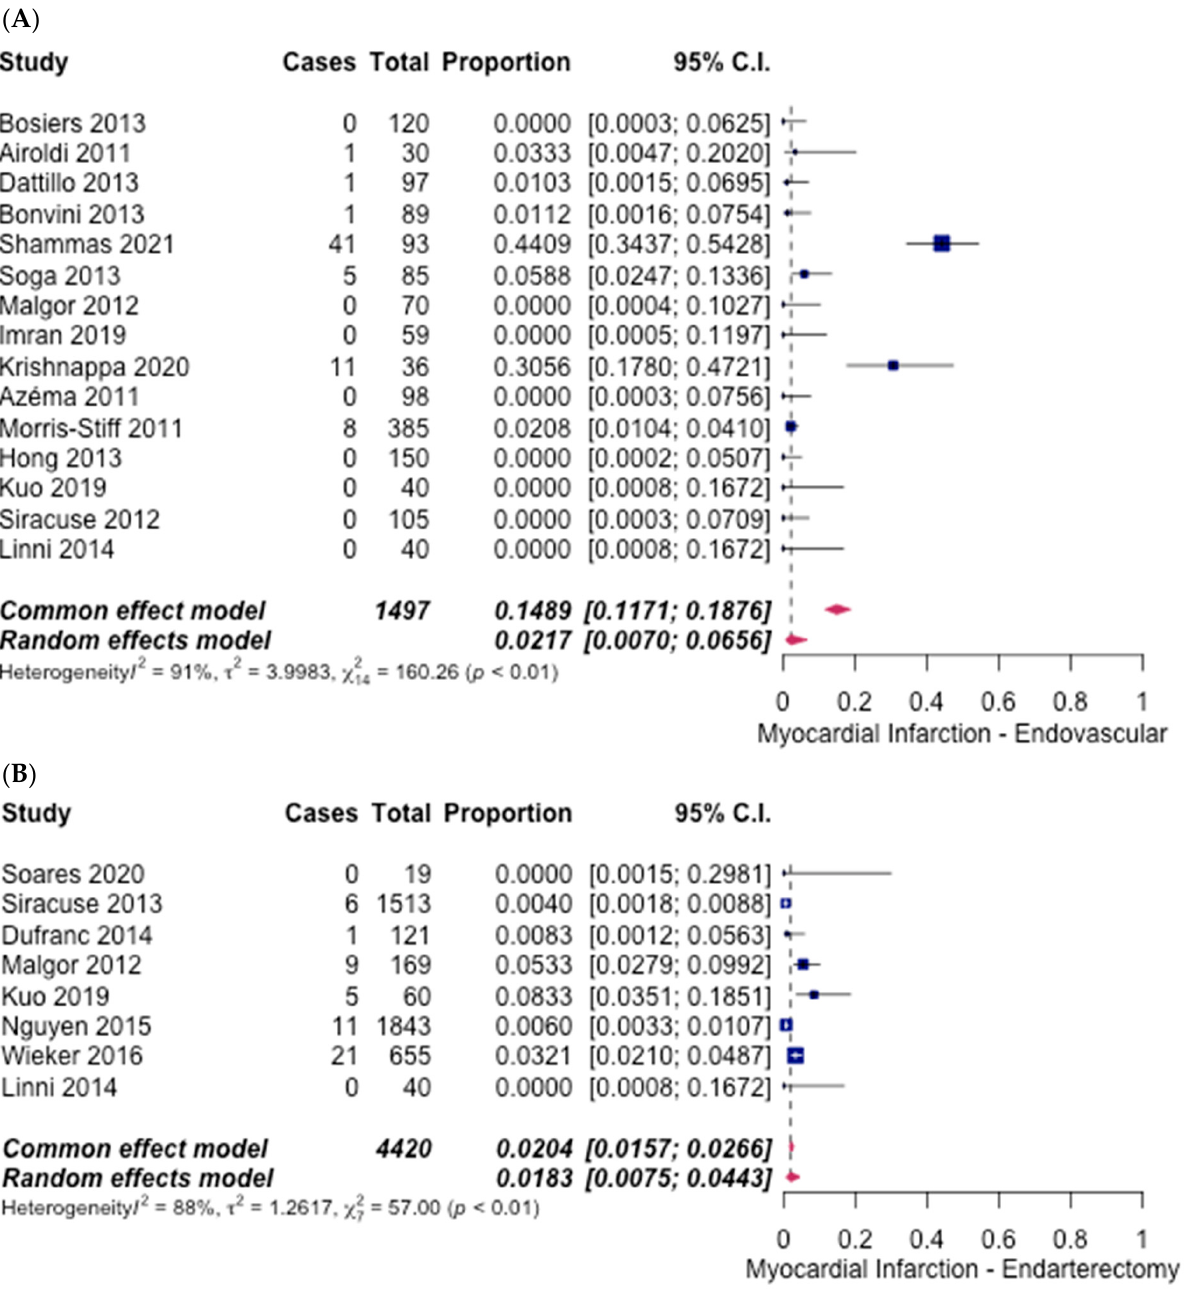
Figure 9. Forest plot for myocardial infarction. ( A ) Endovascular intervention [6,8–16,19–21]. ( B ) Endarterectomy [6,13,21,23,25,28–30]. Wound infection was reported in 1.56% (95% CI [0.68%, 3.54%]) (Figure 10A) of ET (15 studies) [6,7,10,12–22,27] and 6.70% (95% CI [4.95%, 9.02%]) (Figure 10B) of FAE (nine studies) [6,23–26,28–30]. The odds ratio was 0.22 (95% CI [0.15–0.31], p < 0.05), in favour of ET.